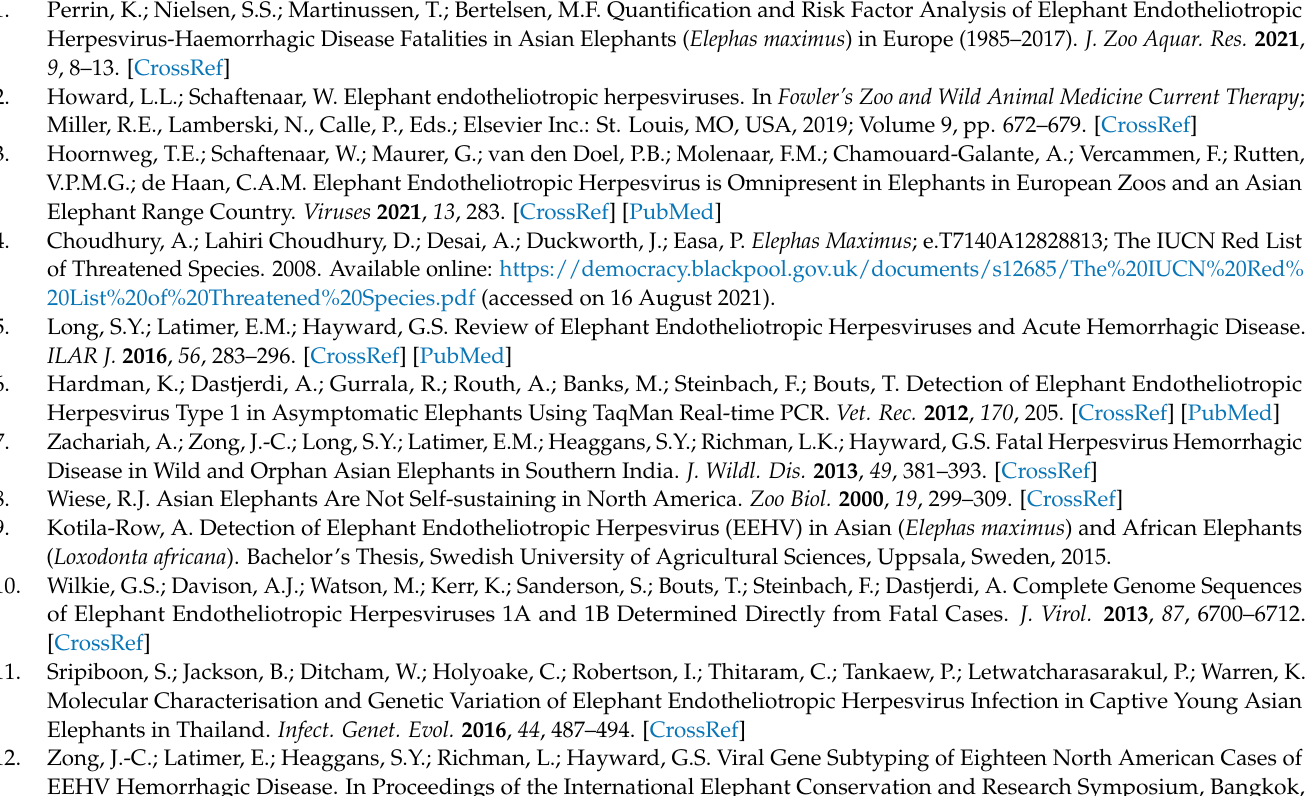
https://doi.org/10.1016/B978-0-323-5528-8.00095-3.